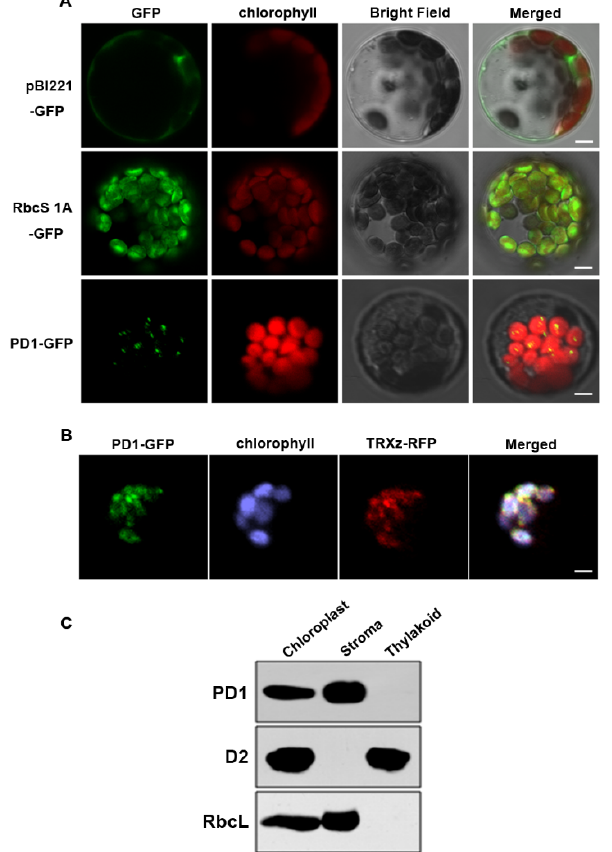
Figure 6. Subcellular localization of the PD1 protein. ( A ) Localization of PD1 protein within chloro- plast by GFP assay. Chimeric proteins were transiently expressed in Arabidopsis protoplasts. pBI221- GFP, control with the pBI221 empty vector; RbcS 1A-GFP, chloroplast control; PD1-GFP, PD1-GFP fusion. Chlorophyll autofluorescence of chloroplasts is shown in red. Bars = 3 μ m. ( B ) Colocalization of PD1-GFP with TRXz-RFP. The fluorescence signal of PD1-GFP overlaps with that of TRXz-RFP within chloroplast nucleoids. Chlorophyll autofluorescence of chloroplasts is shown in purple. Bars = 3 μ m. ( C ) PD1 localizes in the chloroplast stroma. Intact chloroplasts were isolated from the leaves of wild type seedlings and then separated into thylakoid membrane and stroma fractions. Polyclo- nal antisera against the PD1, D2, and RbcL were used in immunoblot analysis.